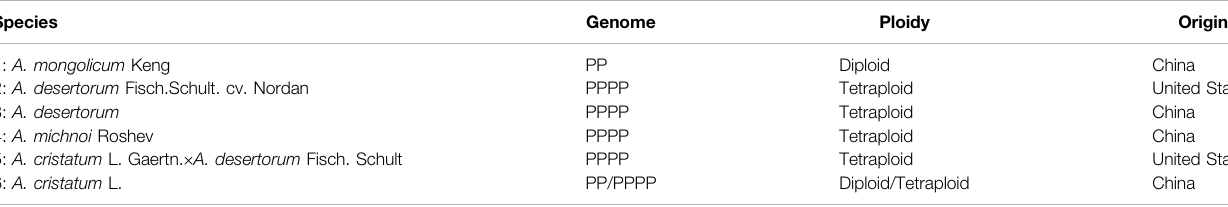
TABLE 1 | Genotypes and phenotypes of six Agropyron species. Species